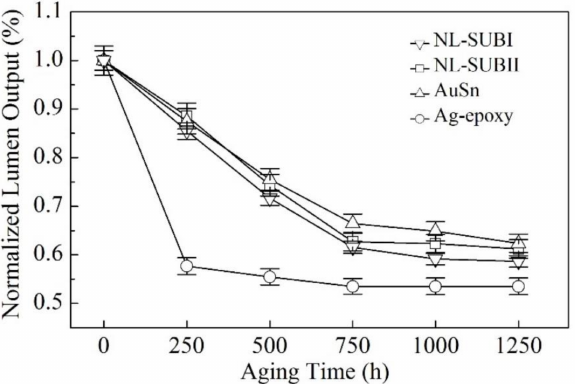
Figure 9. Long-term lumen maintenance of the devices made by the NL bonding method with different substrates and two conventional die-substrate bonding methods as a function of aging time under the stressing condition of an operating current of 700 mA, a relative humidity RH = 85%, and a high environmental temperature of 85 ◦ C: the open downside triangle symbol ( (cid:53) ) represents the experimental data for the device made by NL bonding with substrate type-I; the open square symbol ( (cid:3) ) represents the experimental data for the device made by NL bonding with substrate type-II; the open upside triangle symbol ( (cid:52) ) represents Ag-epoxy bonding with an industrial standard BLT value of 25 ± 2 µ m; and the open circle symbol ( ) represents the experimental data of Ag-epoxy bonding (cid:35) with an industrial standard BLT value of 20 ± 2 µ m. This Wet High Temperature Operating Life (WHTOL) test goes beyond the requirement of the standard JEDEC No. 22-A101C while extending the test duration by 25% from 1000 to 1250